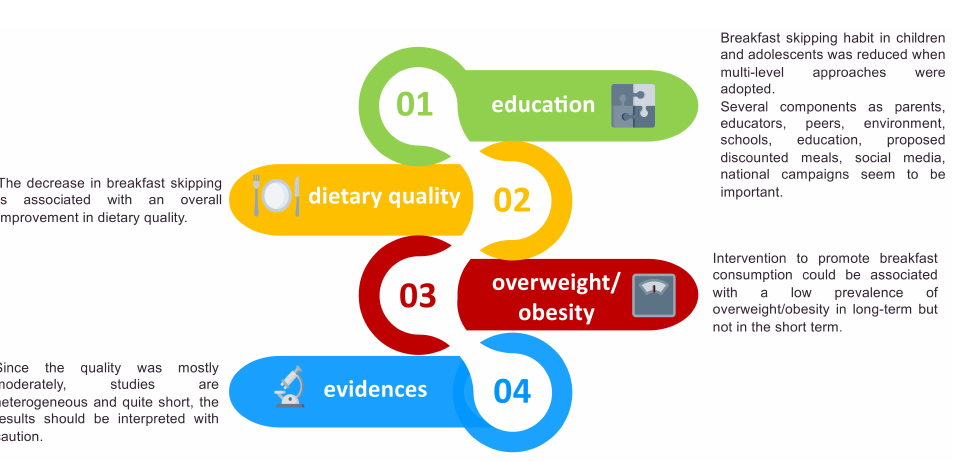
Figure 4. Key messages from the